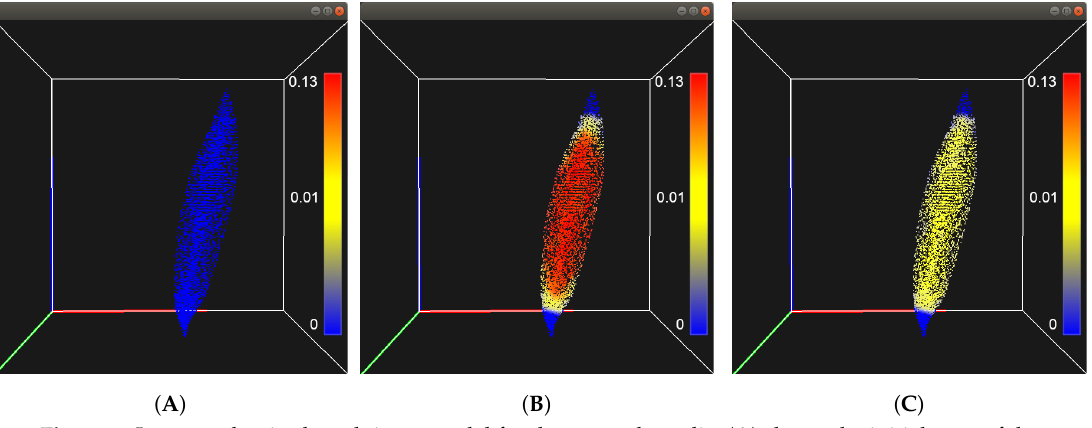
Figure 2. Integrated point-based tissue model for the vastus lateralis. ( A ) shows the initial state of the tissue, ( B ) shows the muscle after being innervated with a stimulus current, and ( C ) shows the muscle returning to its initial shape after the current was removed. The color of the particles represents its displacement with respect to its original